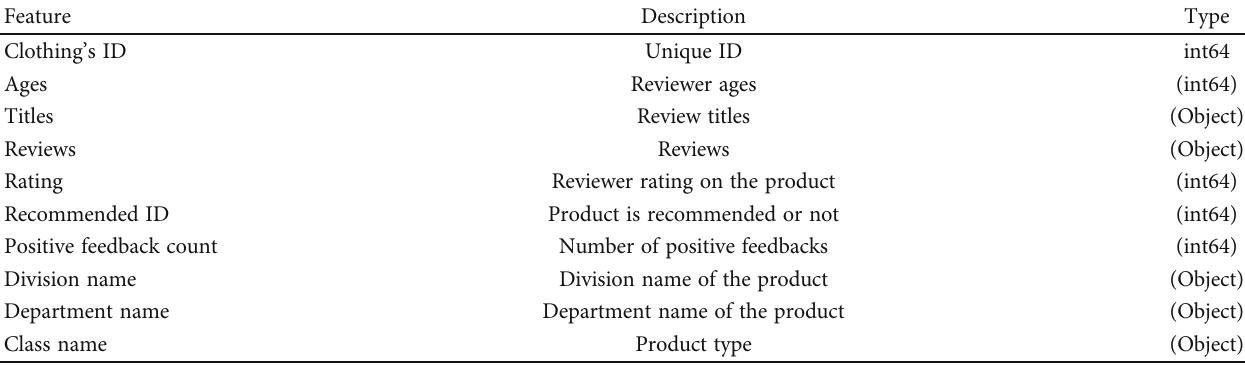
Table 1: Features available with description and data type in the women ’ s clothing